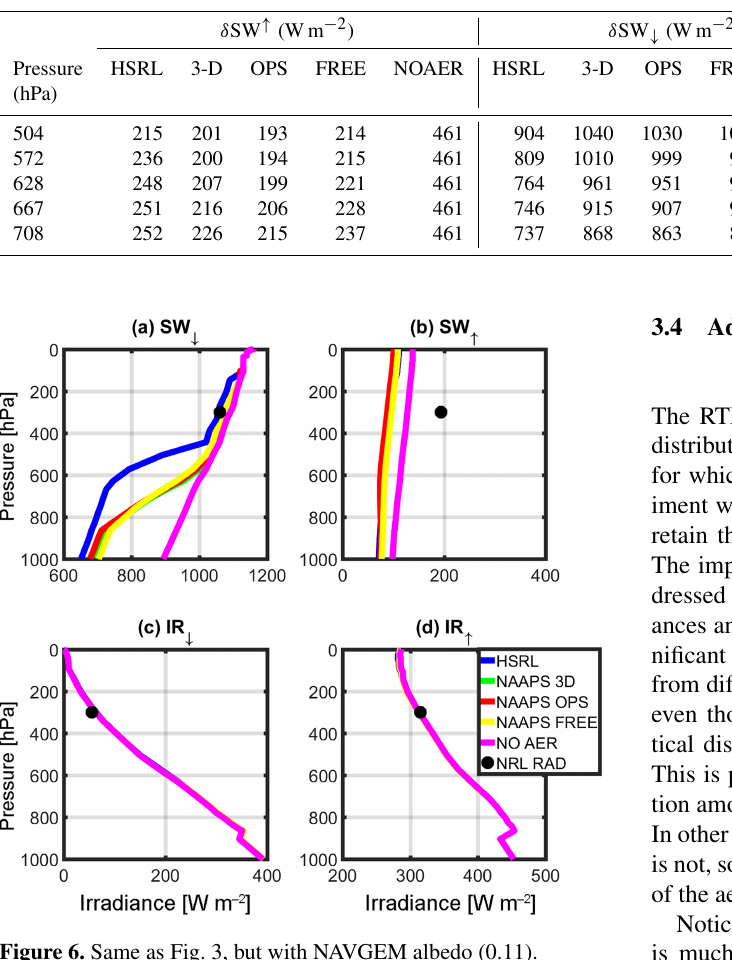
Figure 6. Same as Fig. 3, but with NAVGEM albedo